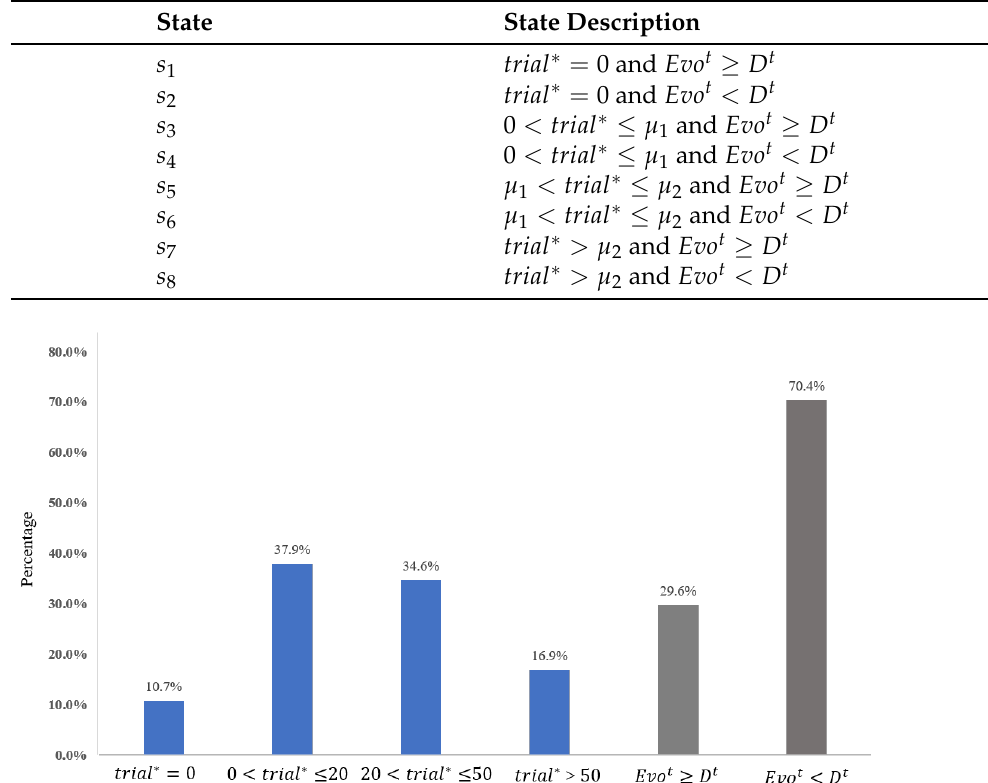
Table 3. The eight state representations.